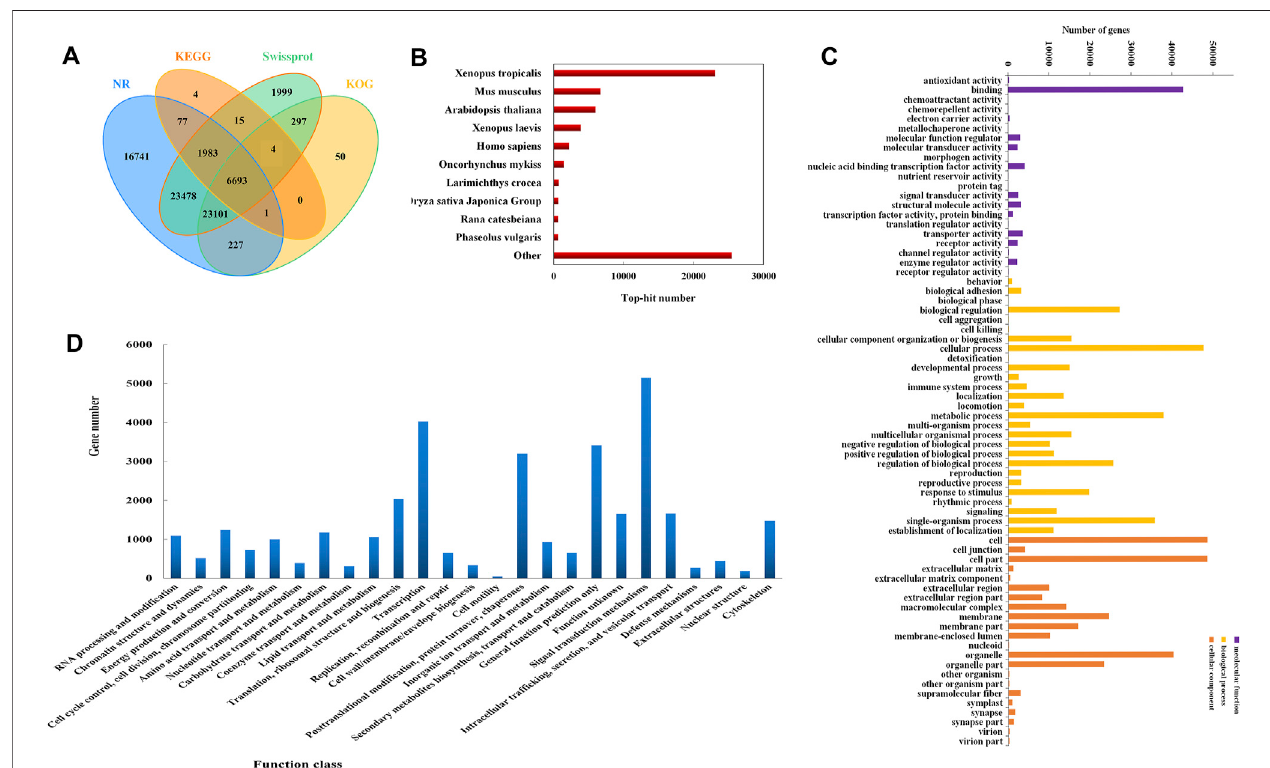
FIGURE 2 | Results of unigenes classi fi cation. (A) The annotation number of unigenes in NR, KEGG, Swissprot, KOG databases. (B) Distribution of annotated unigenes in homologous species by searching NR database. (C) Annotation of GO classi fi cation of unigenes in the transcriptome. GO classi fi cation included three main categories: molecular function, biological process, and cellular component. (D) KOG annotation of the unigenes.